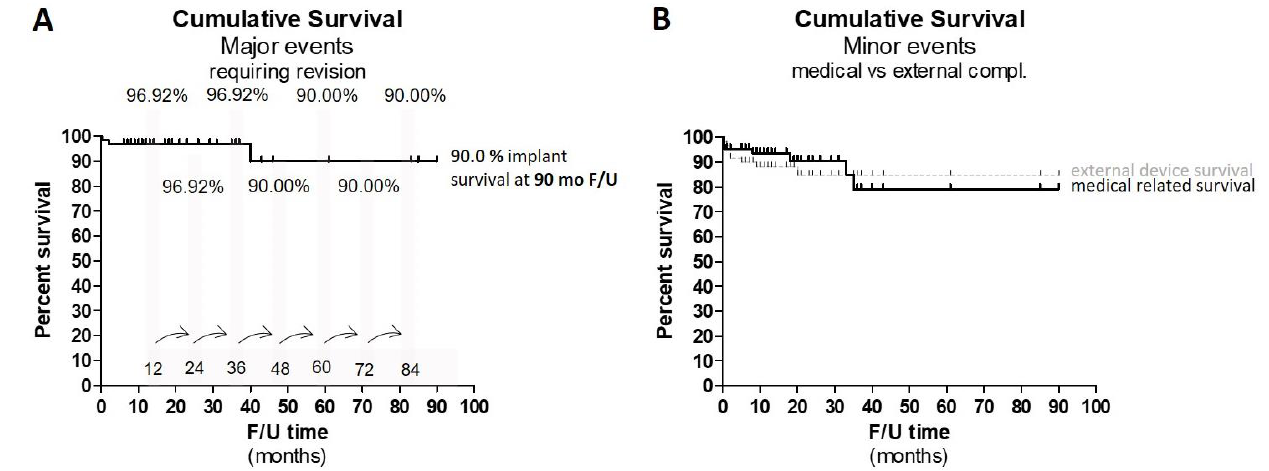
Figure 5. Kaplan – Meier survival analysis. Graph shows the Kaplan – Meier survival analysis calculating the ‘survival’ probability ( A ) for major complications over a course of 90 months. The survival proportion was extracted for each event shown in great bars and indicated by the arrow at the respective event time (months). Up until 36 months, the survival proportion lies at 96.92% and drops then for the remaining 54 months (total 90 months) to 90.0%. ( B ) The ‘survival’ probability for minor complications, split into medical-related conditions and external device problems (too strong a magnet). The survival proportion of the external device survival lies at 86.648%, whereas the survival proportion for the medical-related condition lies at 78.769%. Table 1. Soundfield audiometry (PTA 4).